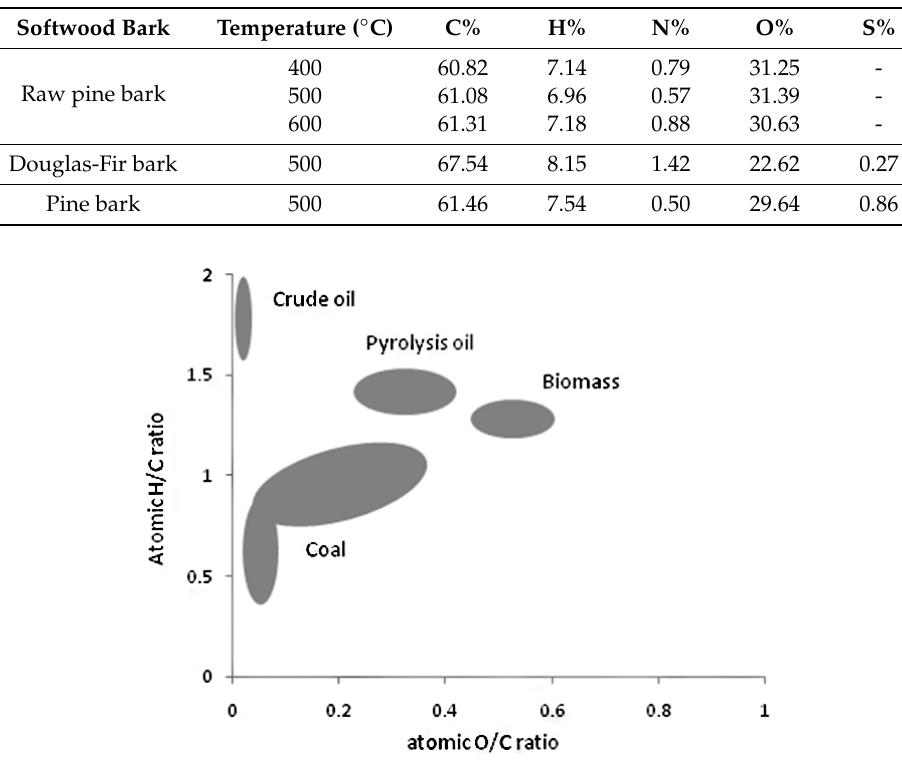
Figure 1. Van Krevelen figure exhibiting the atomic O/C and H/C ratios of fossil materials, biomass, and pyrolysis oils [41,42].